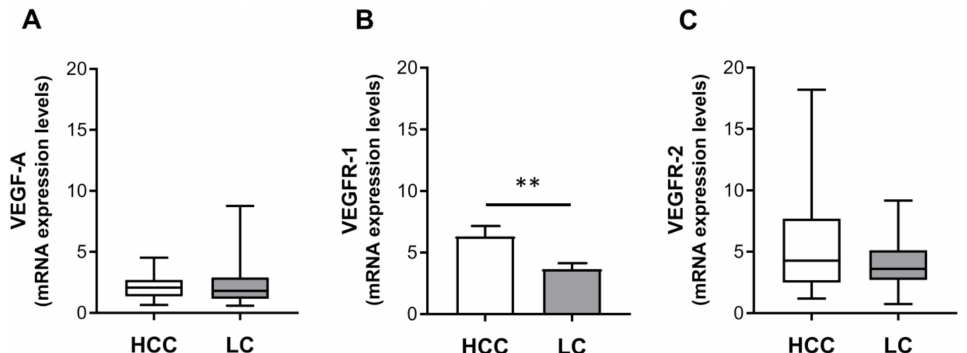
Figure 3. The mRNA expression levels of vascular endothelial growth factor-A (VEGF-A) ( A ), vascular endothelial growth factor receptor (VEGFR)-1 ( B ), and VEGFR-2 ( C ). The mRNA levels were assessed in HCC and paired LC tissues ( n = 26) via qRT-PCR and normalized to housekeeping genes. Median (range) ( A , C ) or mean ± SEM ( B ) gene expression values are shown as a box plot or column bar, respectively. The p values were obtained by Wilcoxon signed rank test ( A , C ) (not statistically significant) or paired t test ( B ) (** p <